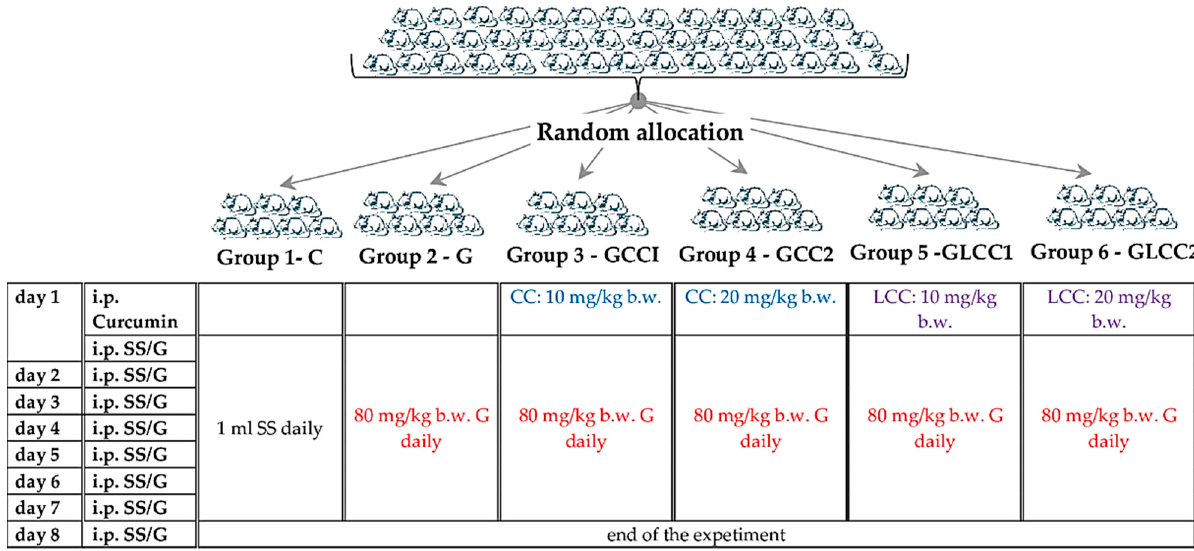
Figure 1. Experimental design schema. SS = saline solution, G = Gentamicin. curcumin solution (CC) and liposomal Curcumin (LCC) solutions were administrated as single dose 30 min before the first dose of Gentamicin, in the first day of the experiment. i.p. = intraperitoneal; b.w. = body weight.